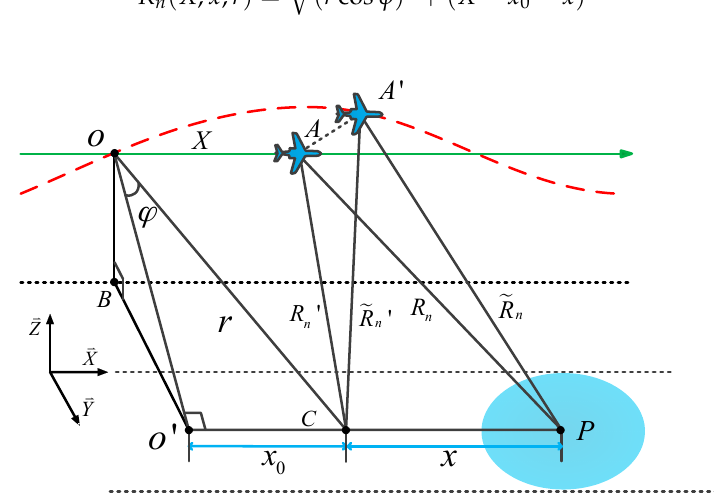
Figure 1. Real SAR imaging geometry.